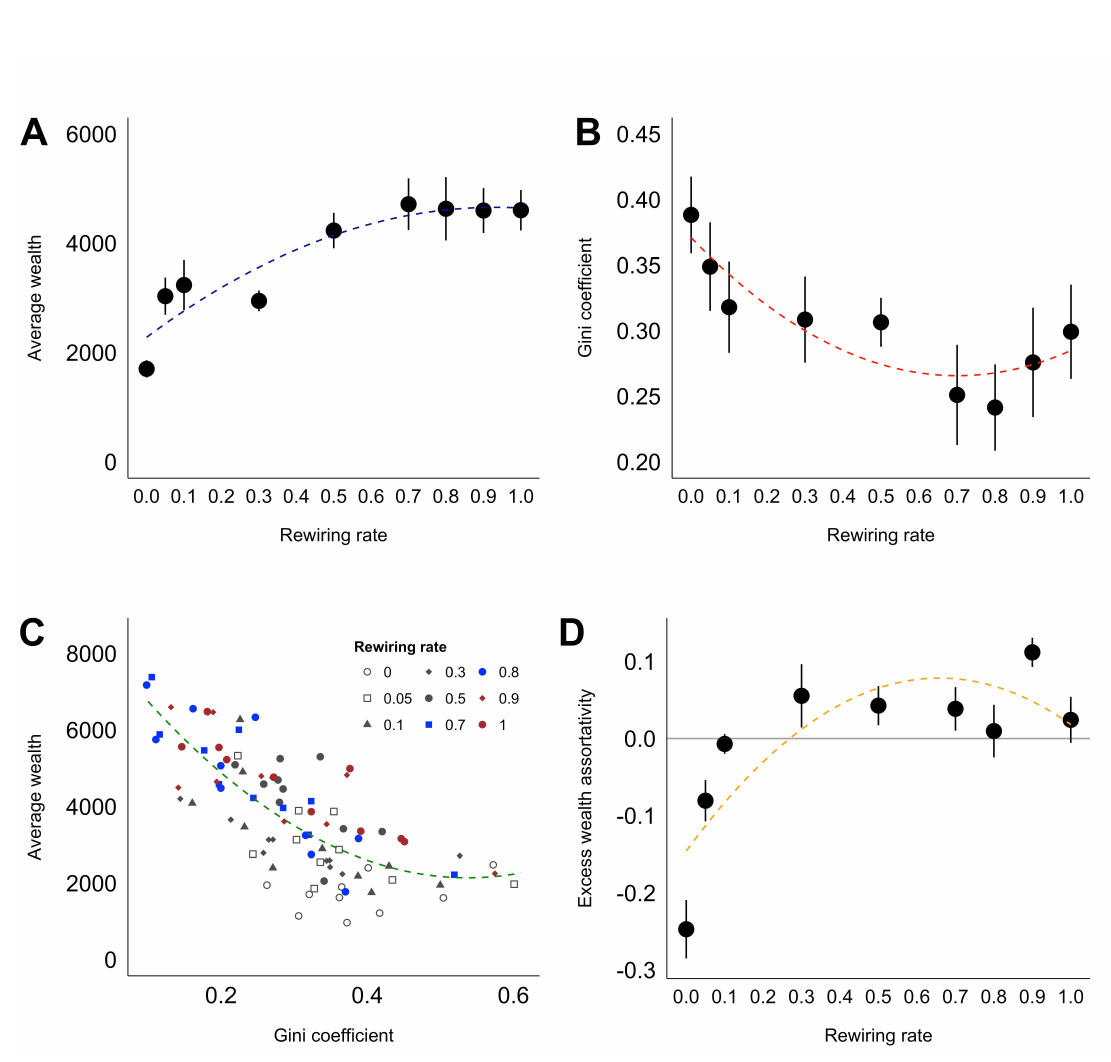
Figure 2: Intermediate levels of the rewiring rate (network fluidity) achieve the highest economic growth and the lowest economic inequality, where average wealth is correlated with Gini coefficient. Results at the final round are shown in all the panels (A) The impact of rewiring rate on Gini coefficient at the final round fits with a quadratic function (blue dashed line). (B) The impact of rewiring rate on average wealth at the final round fits with a quadratic function (red dashed line). (C) The association of Gini coefficient with average wealth at the final round fits with a quadratic function (green dashed line). (D) The association of rewiring rate with excess wealth assortativity fits with a quadratic function (orange dashed line); a horizontal line at 0 represents no assortativity or disassortativity (>0 for assortative, and <0 for disassortative) Error bars, mean ±